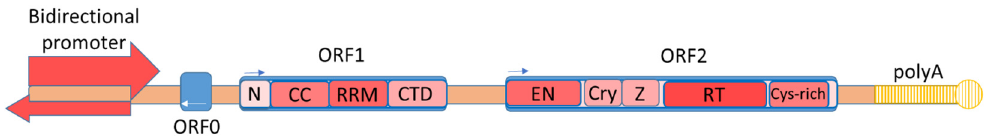
Figure 1. The structure of a full-length copy of L1 retrotransposon. ORF1 consists of an N-terminal domain (N), a coiled-coil domain (CCD), an RNA recognition motive (RRM), and a C-terminal domain (CTD) [18]. ORF2 consists of endonuclease (EN), retrotransposase (RT), a cryptic domain (Cry), a Z-domain (Z), and a C-terminal domain with a cysteine-rich region (Cys-rich) [24].